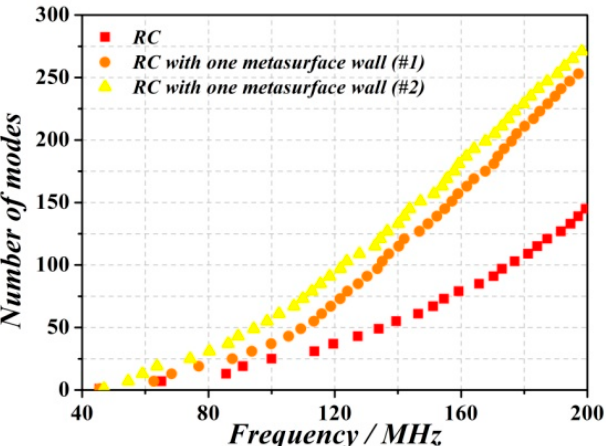
Figure 3. Comparison between the eigenmode solver simulation result of the metallic RC and RC with one metasurface wall (#1 case and #2 case).